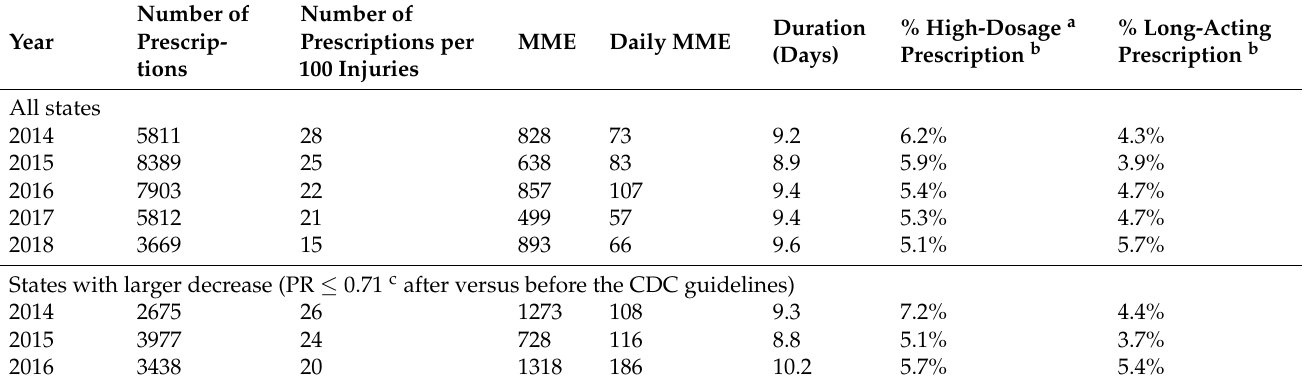
Table 3. Temporal and spatial variations in dispensing practices over